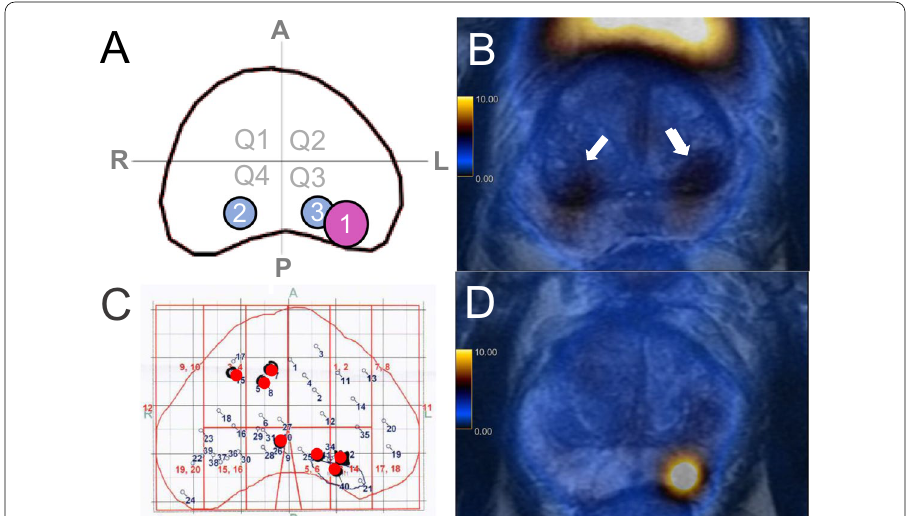
Fig. 2 Example of the method used for lesion localization. A Readout of PSMA PET/MRI by one of the readers with the prostate gland divided in 4 quadrants (Q1: anterior right; Q2: anterior left; Q3: posterior left and Q4: posterior right). The reader delineated three areas of 68 Ga-PSMA-11 uptake and labeled area 1 as suspicious for malignancy and areas 2 and 3 as benign/physiological. B 68 Ga-PSMA-11 PET/MRI images of this patient show physiological bilateral uptake in the central zone (arrows) and a suspicious area with intense uptake in the posterior peripheral zone on the left ( D ). C histopathological map automatically generated by the biopsy fusion software with numbered biopsy cores, red spots represent the localization of needles with Gleason score 3 4, confirming the suspicious lesion on Q3 and showing another lesion on Q1 not depicted on ≥ + PSMA PET/MRI. For the analysis , Q1 was considered false-negative, Q2 true-negative, Q3 true-positive and Q4 false-negative (lesion crossing the midline not depicted by